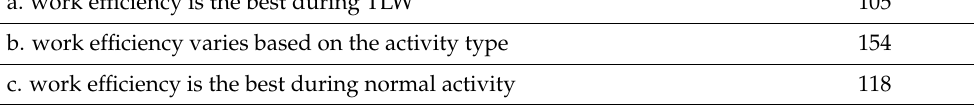
Figure A2. Part ‐ time or full ‐ time employees. Figure A2. Part-time or full-time employees. 4. Do you consider that you performed the telework activity with the same efficiency as at the office?